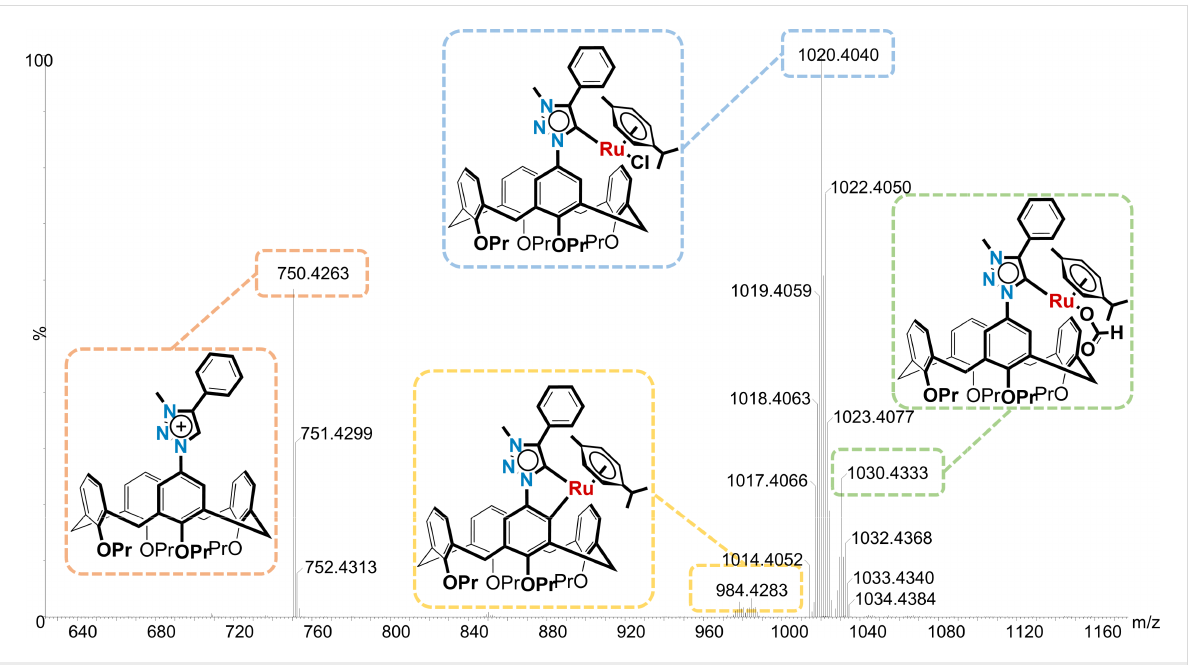
Figure 4: High-resolution mass spectrum (ESI + ) of putative ruthenacycle calix[4]arene 13 .